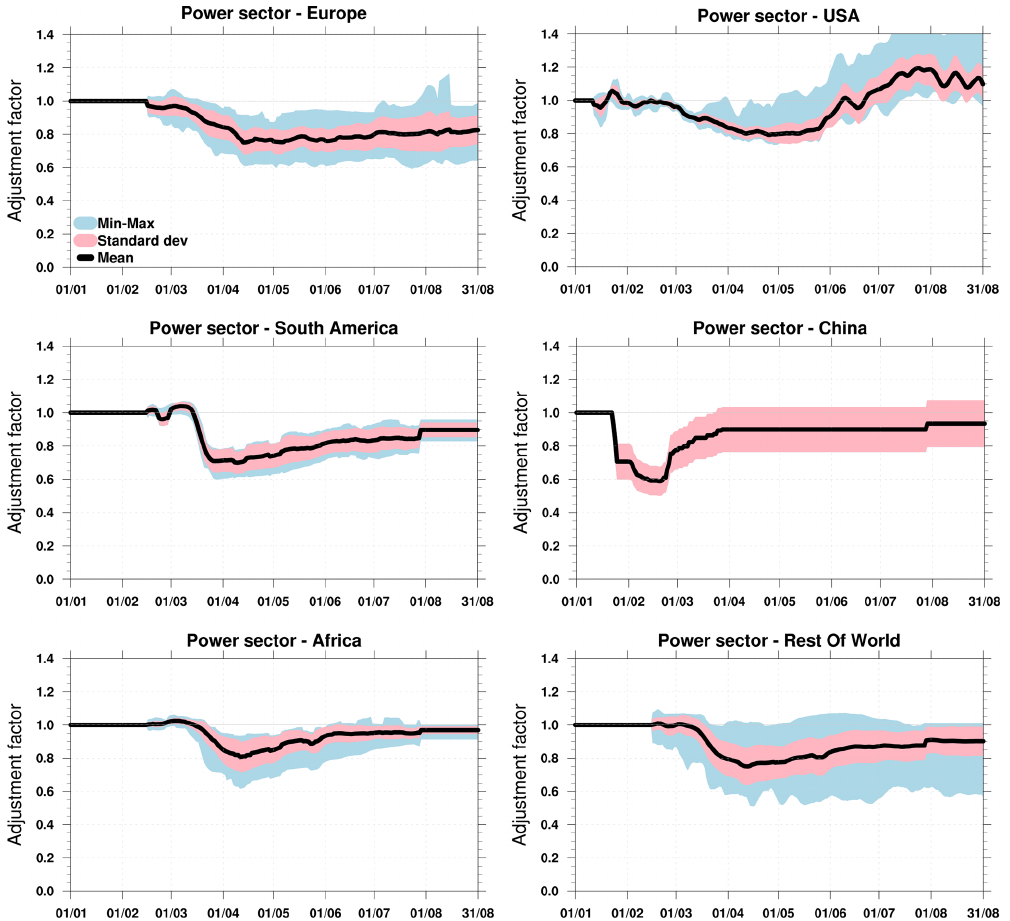
Figure 6. Daily AFs for power sector from January to August 2020 over Europe, USA, South America, China, Africa and the rest of the world. These estimations are derived from multiple data sources (Table 1). The standard deviation values (light pink) result from the AFs for the individual countries or states/provinces. The light-blue color indicates the range of the minimum and maximum